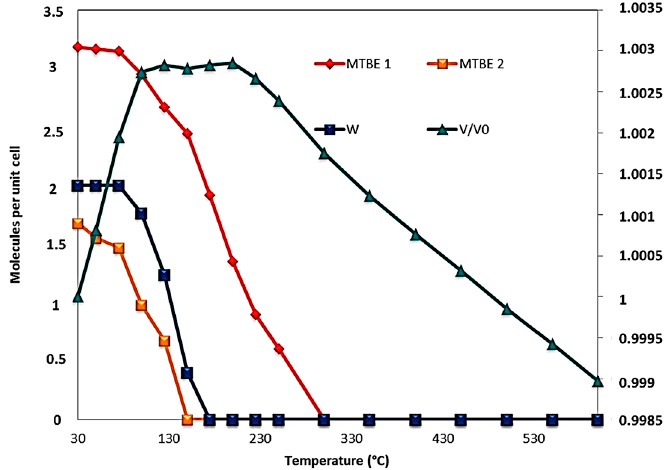
Figure 4. Evolution of MTBE and water (W) molecules and unit cell volume as a function of temperature.